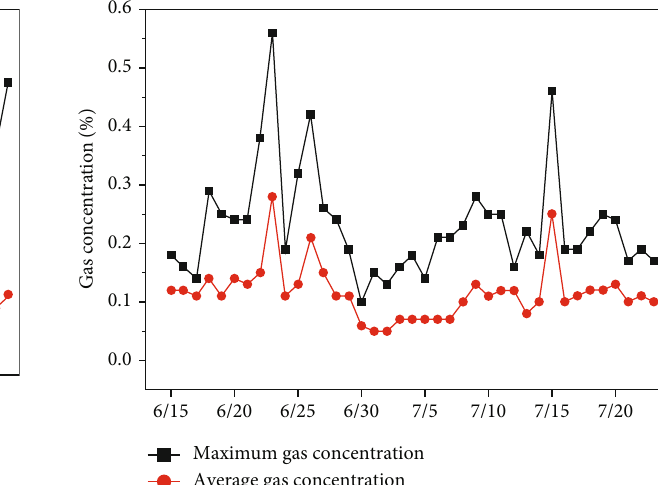
Figure 15: Curve of gas concentration in upper